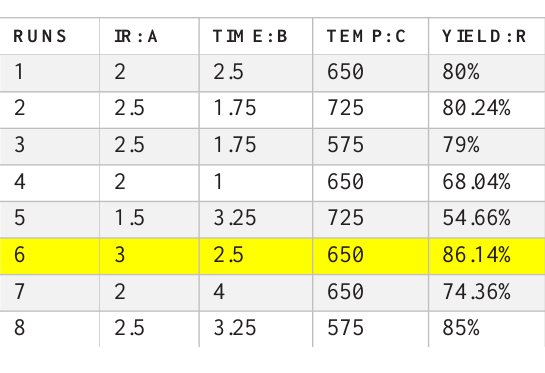
The predicted values of yield using CCD